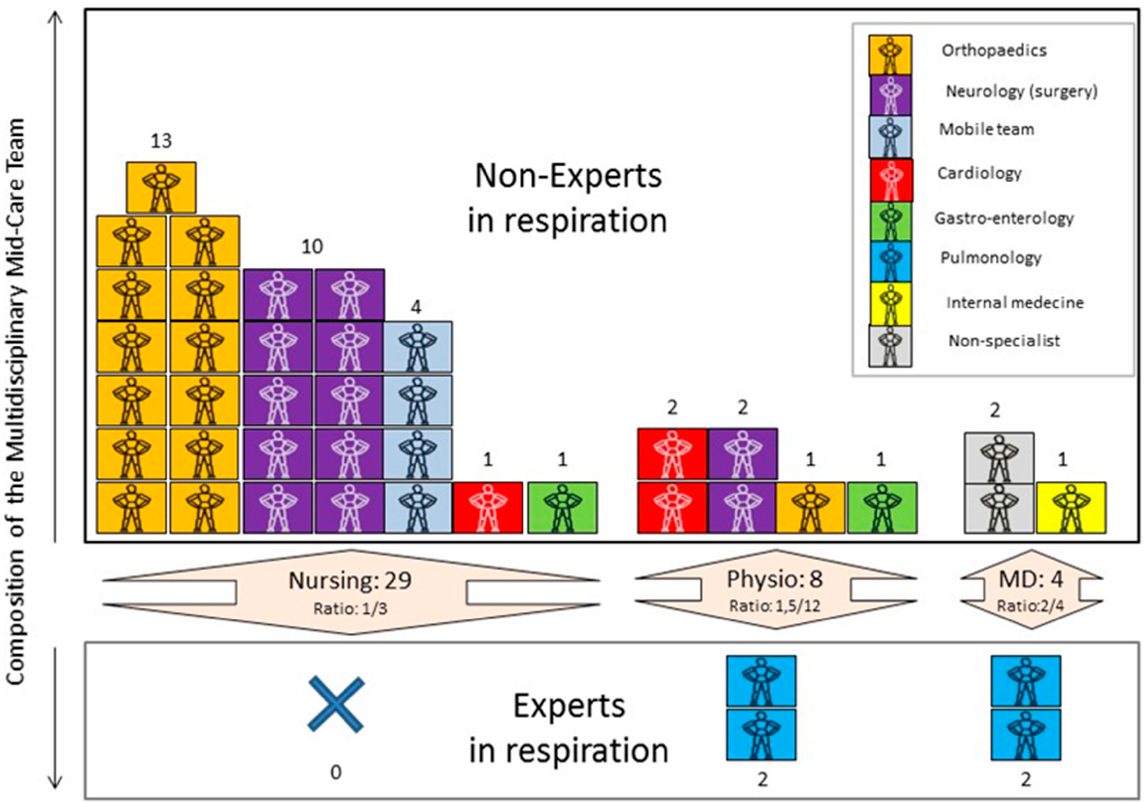
Figure 2. Reorganization of the Middle Care team during the COVID-19 pandemic.